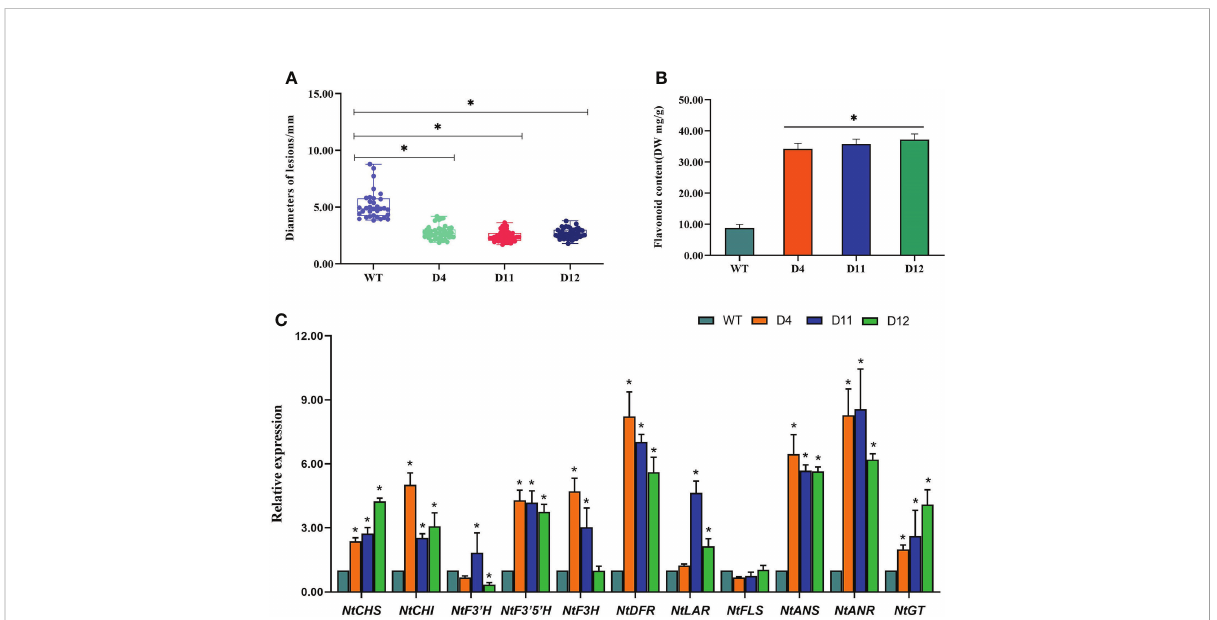
FIGURE 6 (A) Statistical analysis of the disease spot size after C fructicola infection. (B) The fl avonoid content in transgenic tobacco. (C) The expression level of key genes involved in the fl avonoid biosynthesis pathways. Asterisks indicate statistically signi fi cant differences from the WT ( “ * ” P < 0.05).